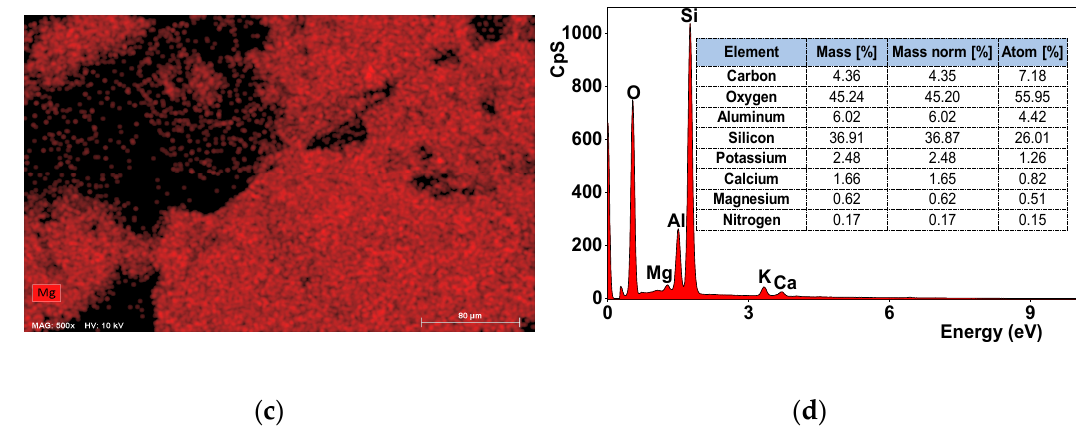
Figure 1. SEM image of zeolite with magnesium mapping ( a ) and EDS ( b ) spectra, and their respective image ( c ) and spectra ( d ) for Mg-form activated zeolite.